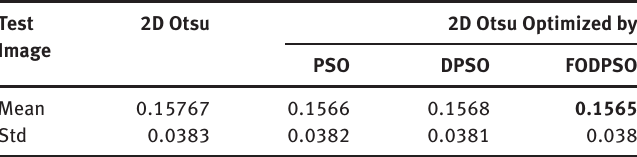
Table 6: Evaluation Results Using Regional NU.